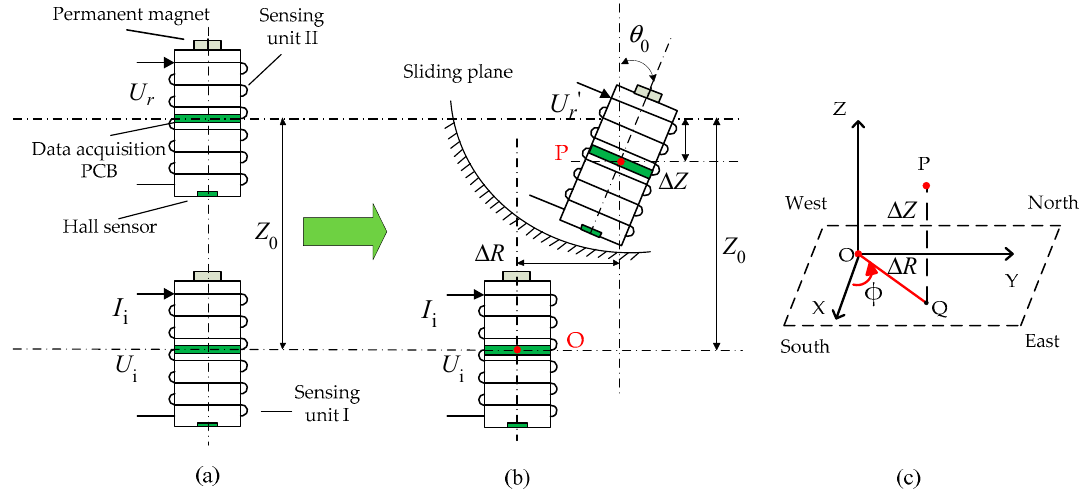
Figure 2. Schematic diagram of the previously designed measuring unit. ( a ) Initial geometrical setting; ( b ) occurrence of relative horizontal displacement ∆ R , vertical displacement ∆ Z and tilt angle θ 0 ; ( c ) relative 3D position between points O and P.